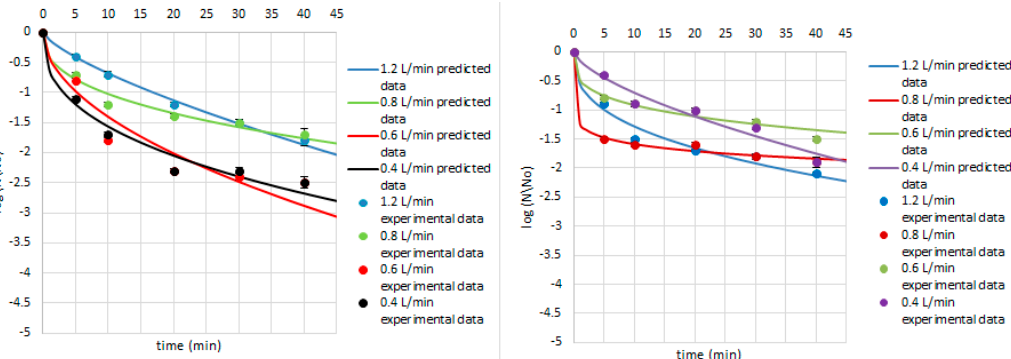
Figure 6. Survival of B. pumilus on the cardamom seed ( left ) and juniper berry ( right ) matrix treated with ozone doses stimulated with flow rate of 1.2, 0.8, 0.6, and 0.4 L/min after 5, 10, 20, 30, and 40 min. Solid line: prediction of the Weibull model (egns 8–9), dotted line: bacterial log counts.